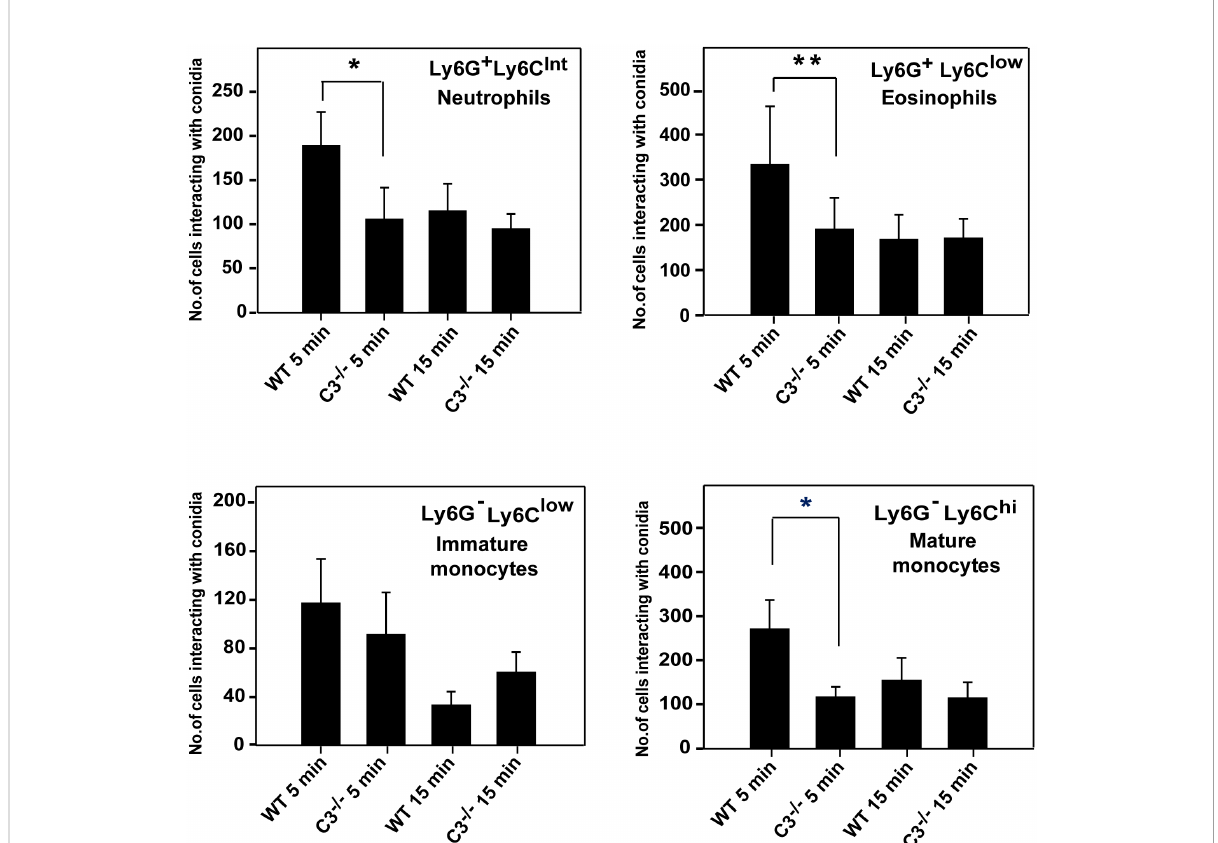
FIGURE 7 In vivo uptake of A. fumigatus conidia by monocyte subsets, eosinophils, and neutrophils. A. fumigatus conidia 1x10 6 labelled with CFSE were injected intravenously in wild-type (WT) and C3 -/- mice (both on BALB/c background), and blood was collected from infected mice from the retro-orbital sinus at 5 min and 15 min post-infection. Following RBC lysis, cells were stained for neutrophils (Ly6G + /Ly6C Int ), eosinophils (Ly6G + /Ly6C low ), and monocyte subsets (Ly6G - /Ly6C low and Ly6G - /Ly6C hi ) with fl uorescent antibody and uptake/interaction of conidia was examined by FACS. Results represent the mean ± SD of three independent experiments. Immune cells from WT mice showed more interaction with conidia in 5 min than the cells from C3 -/- mice. The statistical signi fi cance in complement de fi cient mice was evaluated by Mann Whitney test (**p < 0.01 *p <